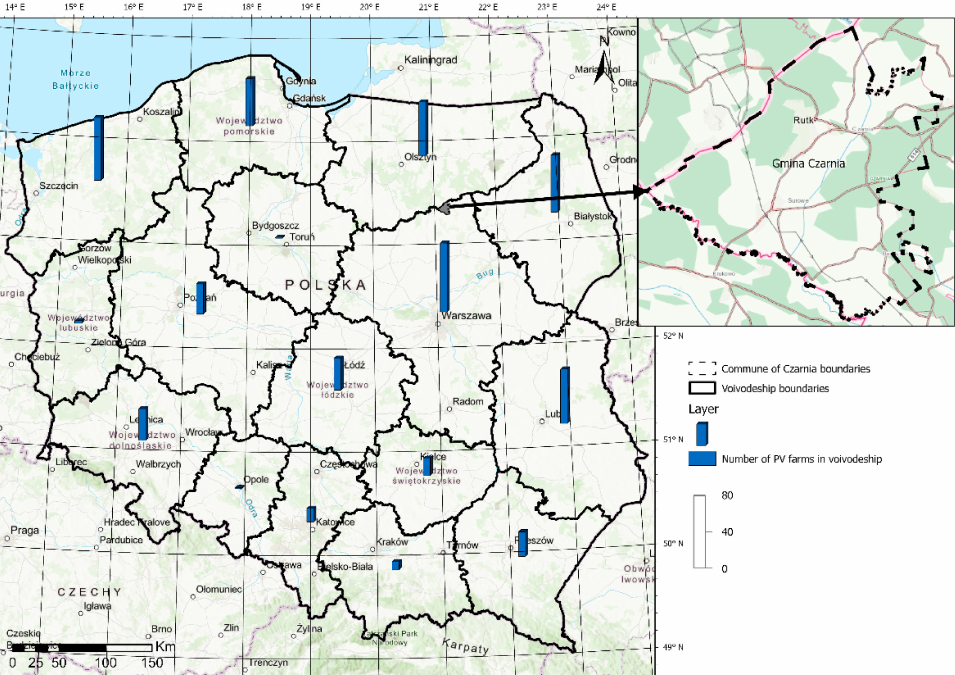
Figure 10. The weights of significant Quantitative analysis of the identified photovoltaic farms and the location of the test area for which the capabilities matrix to locate PV farms and the map of decision alternatives have been